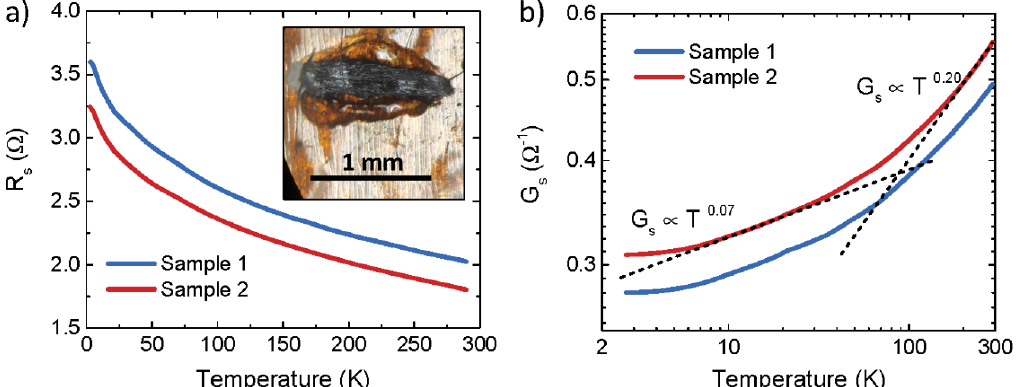
Figure 5. ( a ) Sheet resistance as a function of temperature for two different samples of biochar derived from exhausted tea leaves in linear scale. Inset is an optical image of biochar Sample 1 connected with gold wires and silver paste; ( b ) Corresponding sheet conductance as a function of temperature in log-log scale. Dashed lines indicate two different power-law scalings of the sheet conductance with temperature.